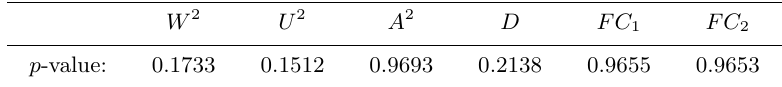
Table 3. Breaking stress of carbon fibres: Goodness-of-fit tests. W 2 U 2 A 2 D FC 1 FC